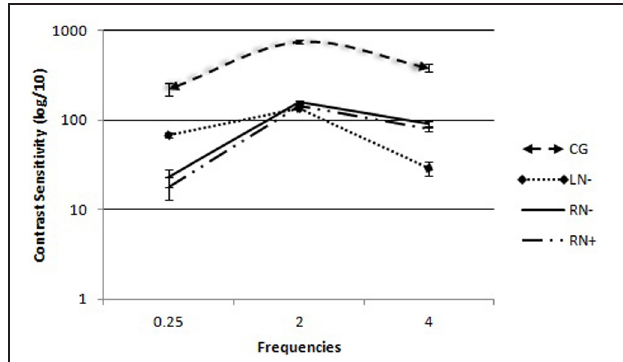
FIGURE 2 | Contrast sensitivity curves for spatial frequency in each group: control group (CG), left brain-damaged patients not affected by visuo-spatial neglect (LN − ), right brain-damaged patients without any sign of visuo-spatial neglect (RN − ), and right brain-damaged patients affected by visuo-spatial neglect (RN + ). The vertical lines show the standard error of the mean (SEM) for each frequency (0.25, 2.0, and